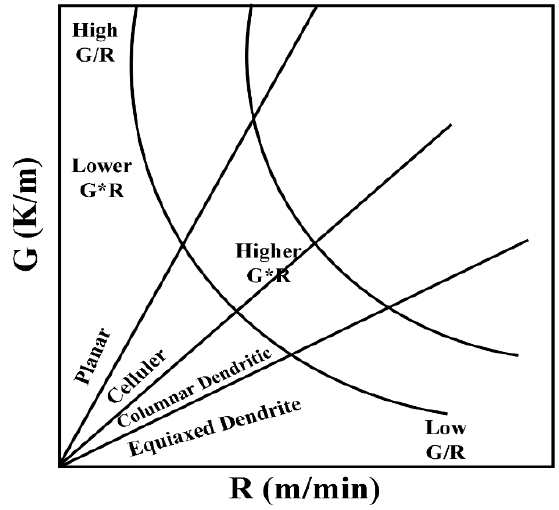
Figure 3. The effects of G and R on the morphology and scale of the solidified microstructure: G/R determines the morphology of the solidified structure; G*R determines the size of the solidified structure. Reprinted with permission from Ref. [31], 2022, Elsevier.